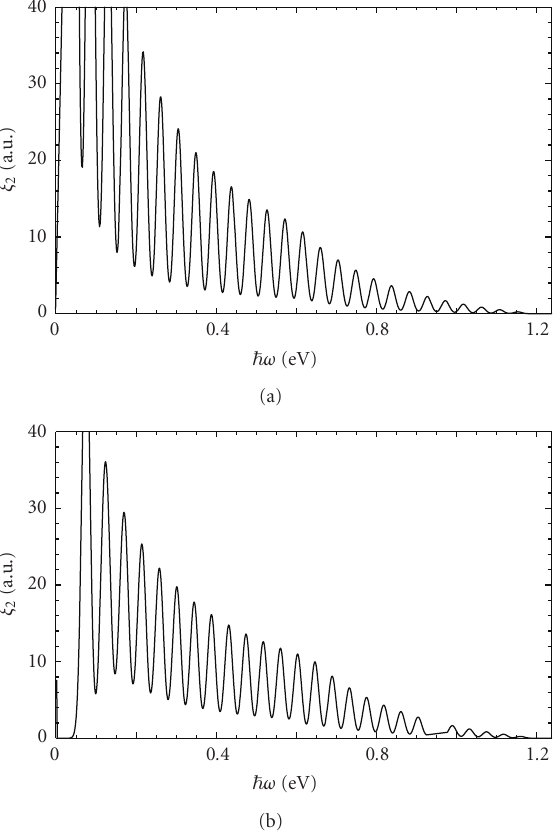
Figure 3: Optical absorption power for (a) 173-AGNR and (b) 100- ZGNR as a function of the irradiation energy.